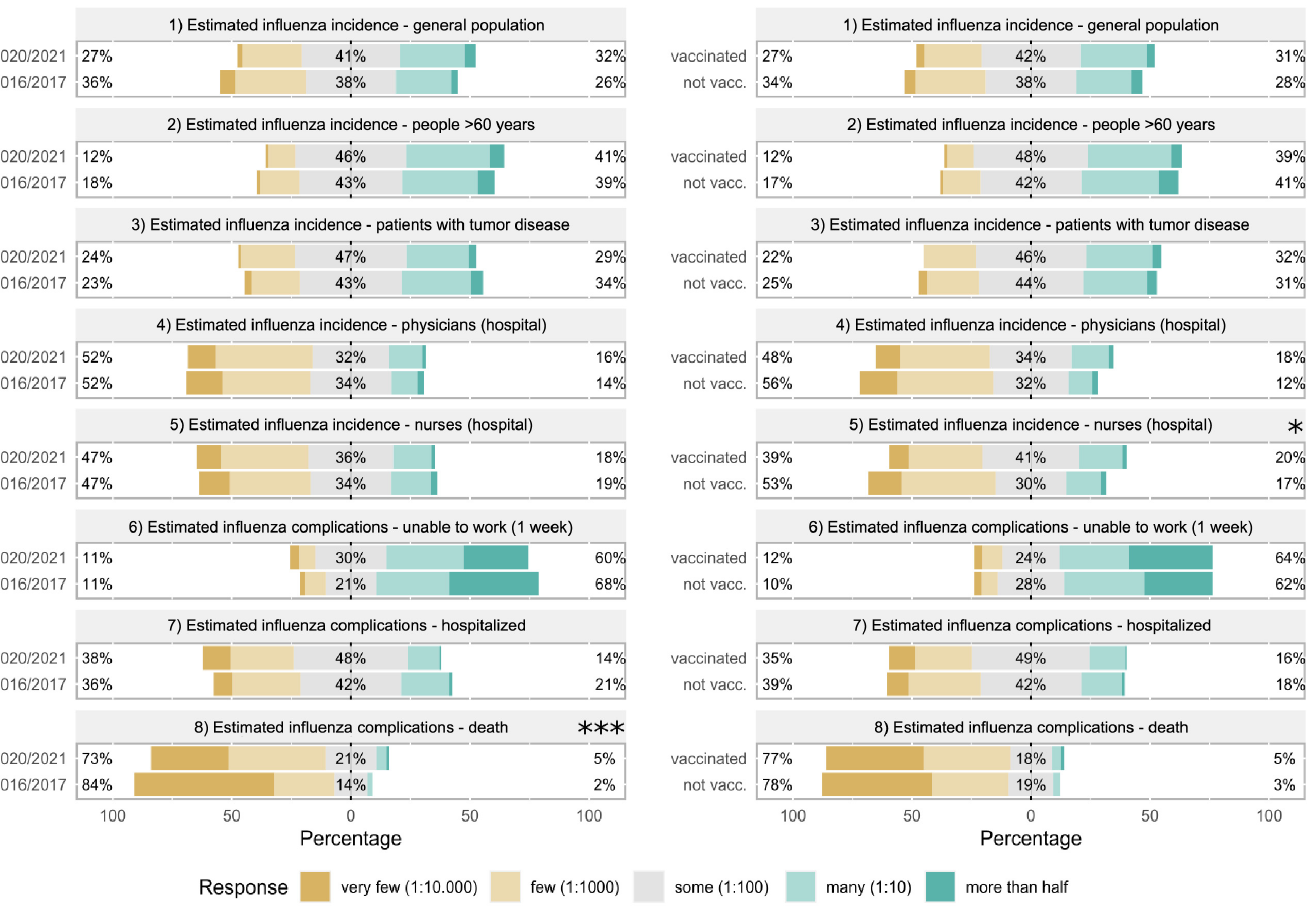
Fig 2. Comparison of estimated frequencies of influenza infections and complications between 2016/2017 and 2020/2021 or between vaccinated and unvaccinated respondents in 2020/2021. Estimated frequency of influenza infection and its complications rates were assessed on a 5-Point Likert scale and compared between the seasons 2016/2017 and 2020/2021 (left) or between vaccinated and not vaccinated respondents in 2020/2021 (right). Statistics were performed after conversion of ordinal answer levels to a numeric scale using Mann-Whitney U tests, p-values are depicted as � < 0.05, �� < 0.01 and ��� < 0.001.